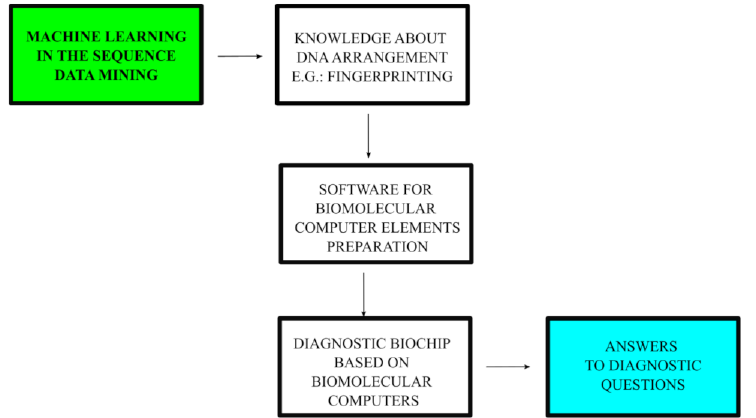
Figure 2. Schematic diagram of the new approach to using biomolecular computers as diagnos- tic